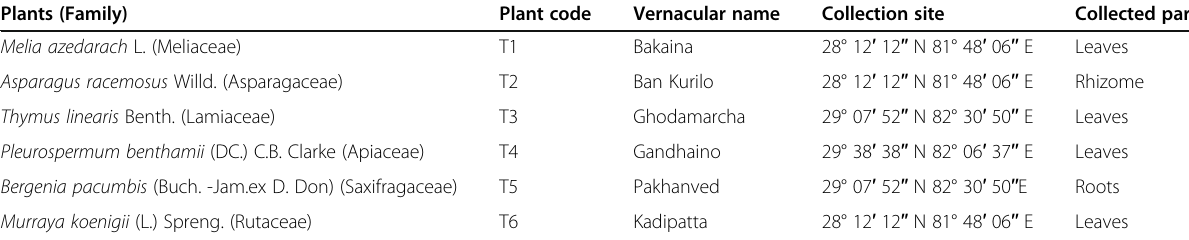
Table 1 Detail on plants collection Plants